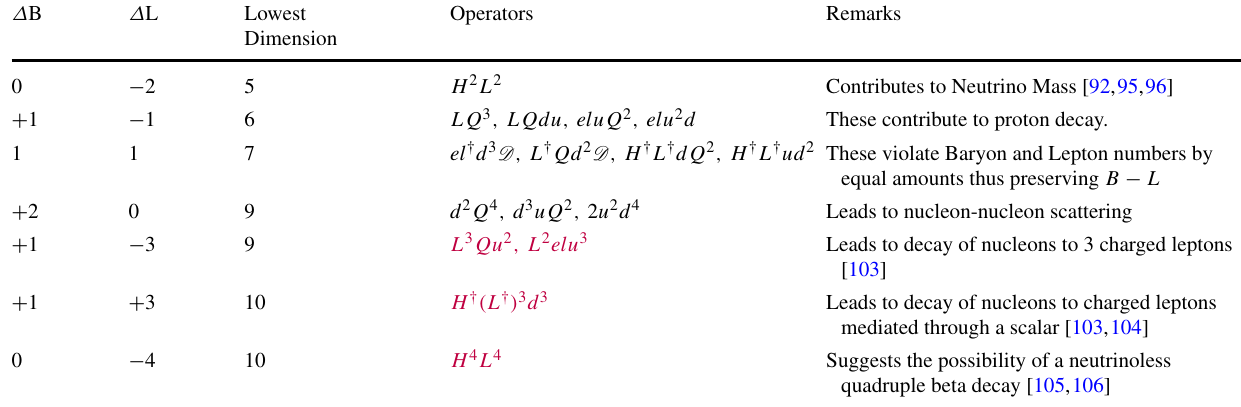
Table 27 Baryon and Lepton number violating SM operators. The operators in red vanish for N f = 1. The hermitian conjugates of each of these operators will have Δ B → − Δ B and Δ L → − Δ L Δ B Δ L Lowest Operators Dimension Contributes to Neutrino Mass [92,95,96] LQ 3 , LQdu , eluQ 2 , elu 2 d These contribute to proton